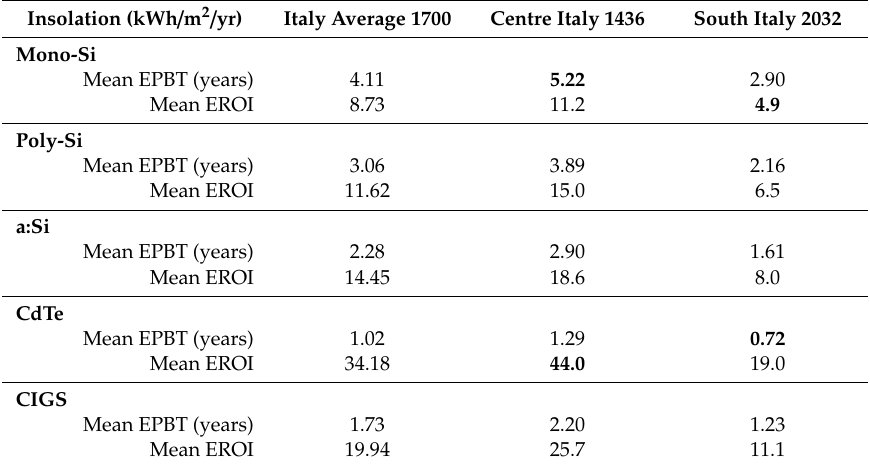
Table 5. Mean harmonized EPBT and EROI for multiple insulations in the Italian area. Insolation (kWh / m 2 /